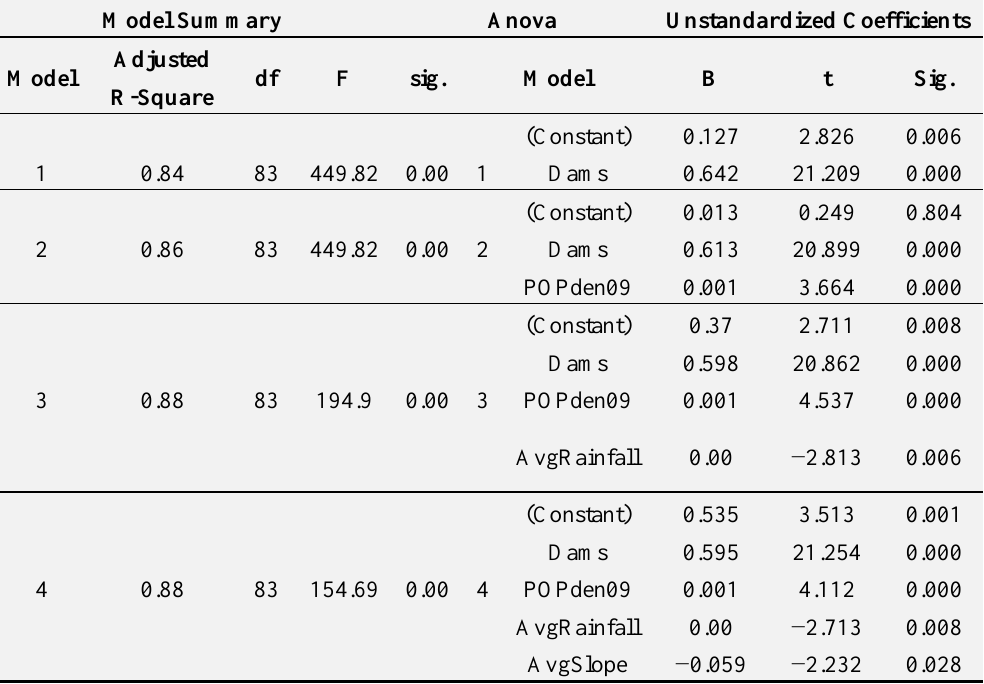
Table 2. Multivariate linear step-wise regression model results. Coefficient of determination r 2 = 0.88, ( p < 0.01, t = 154.69) showing significant variables of dams ( p < 0.01), population density ( p < 0.01), average rainfall ( p < 0.01) and average slope ( p < 0.05), in predicting greenhouse